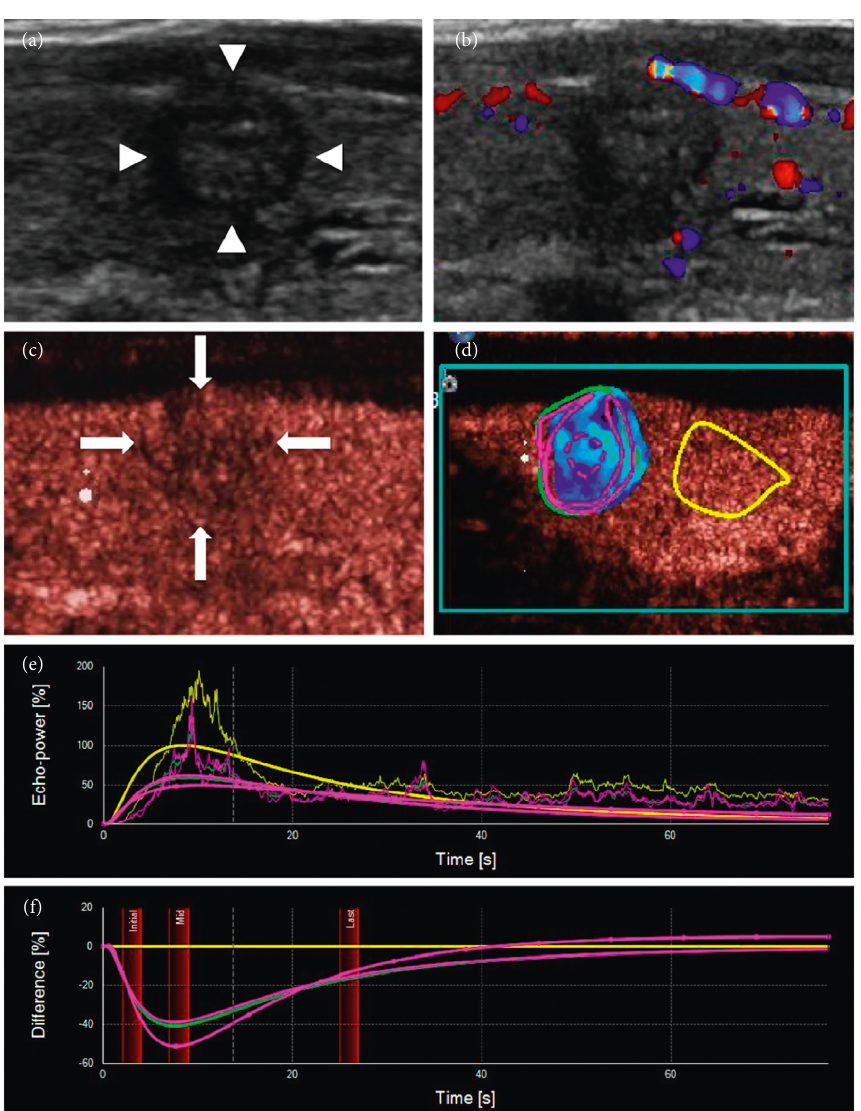
Figure 9: (a, b) A 55-year-old female had a hypoechoic solid nodule in her thyroid, with a maximum diameter of 6mm and a hypoechoic halo around the nodule, uneven in thickness. The margin of the nodule was not clear, and no blood flow signal was detected in the nodule. The nodule was classified as TI-RADS 4 and was considered to might be a mummified nodule. (c) CEUS showed that the nodule had uneven low enhancement, unclear margin, and no ring enhancement, which was similar to the enhancement mode of a PTC. (d–f) SonoLiver software was used to analyze the contrast video. According to the analysis results, the nodule was considered to be a PTC. Postoperative pathology confirmed this